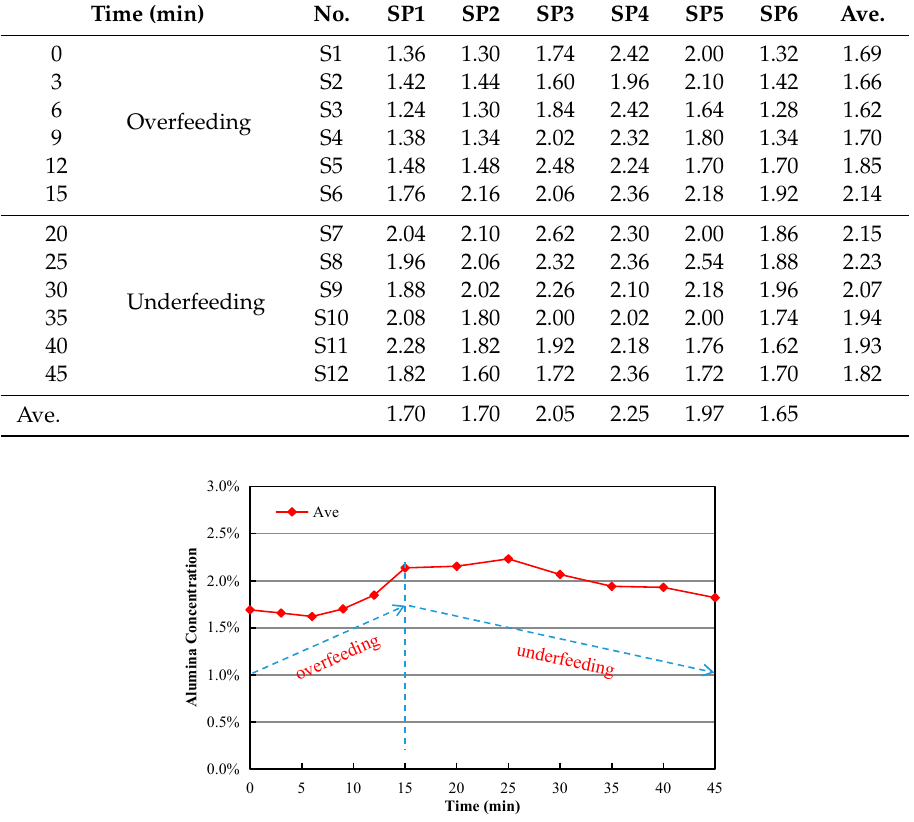
Table 4. Measured data of alumina concentration (wt%) in a typical 500 kA cell.